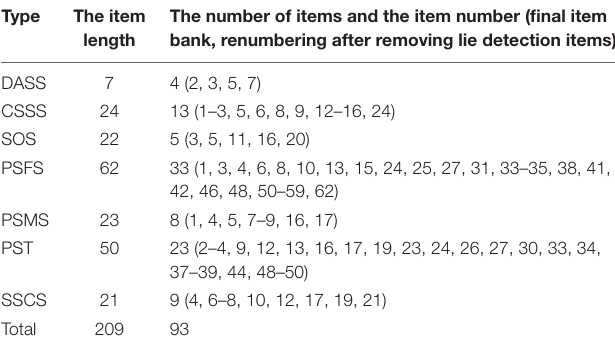
TABLE 2 | The source of the item bank.